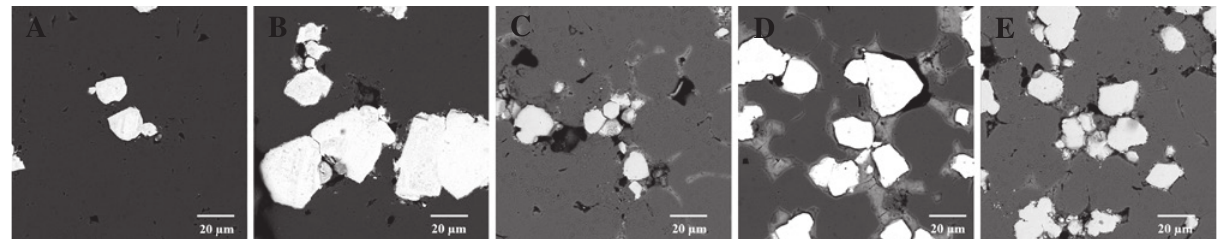
Figure 9: SEM micrographs of the internal microstructure of the composite Cu-W with different volume fractions of reinforcing particles: